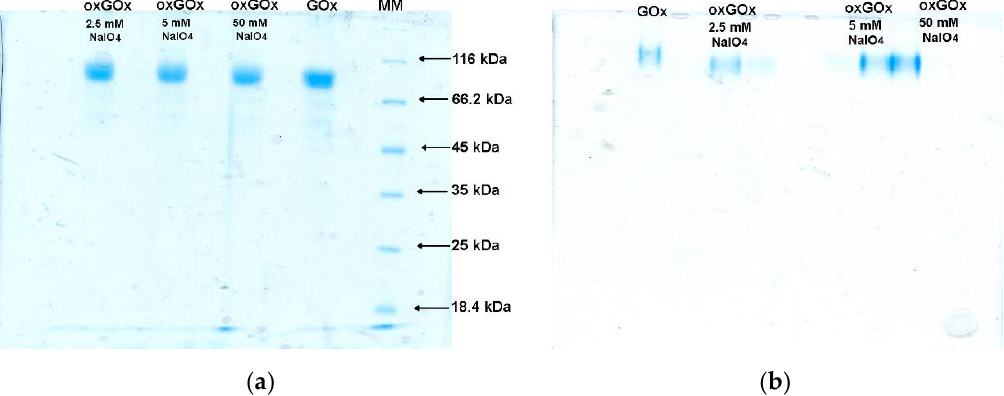
Figure 1. ( a ) SDS and ( b ) native PAGE electrophoresis of commercial GOx, periodate oxidized protein (oxGOx) using 2.5, 5, and 50 mM NaIO 4 . MM — molecular weight markers.